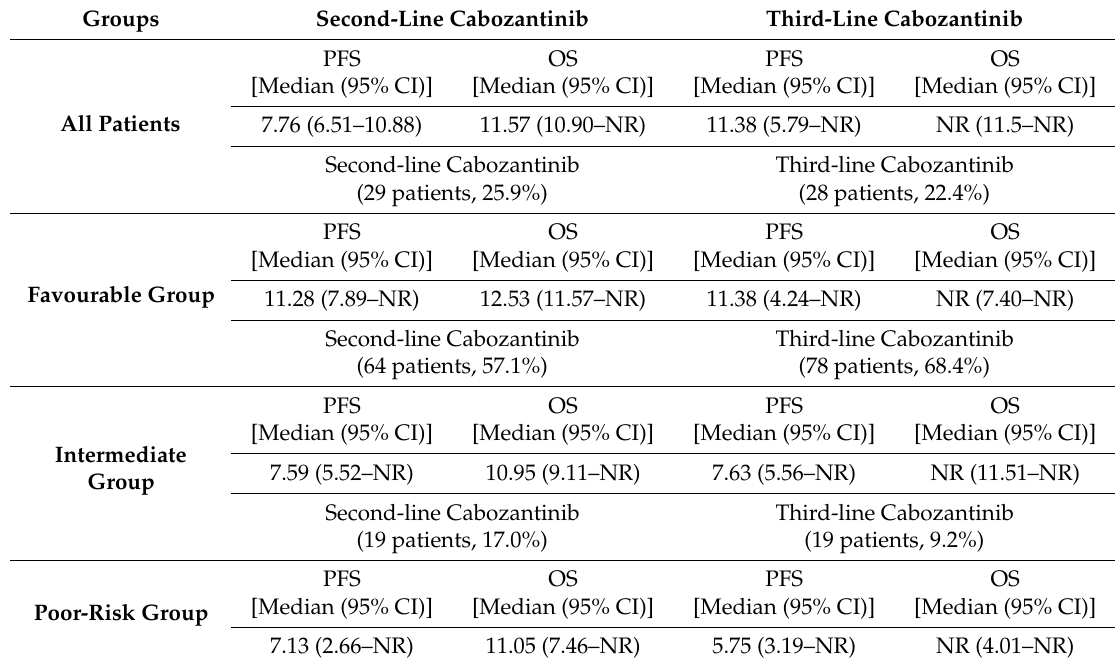
Table 3. Progression-free survival and overall survival obtained by cabozantinib in our